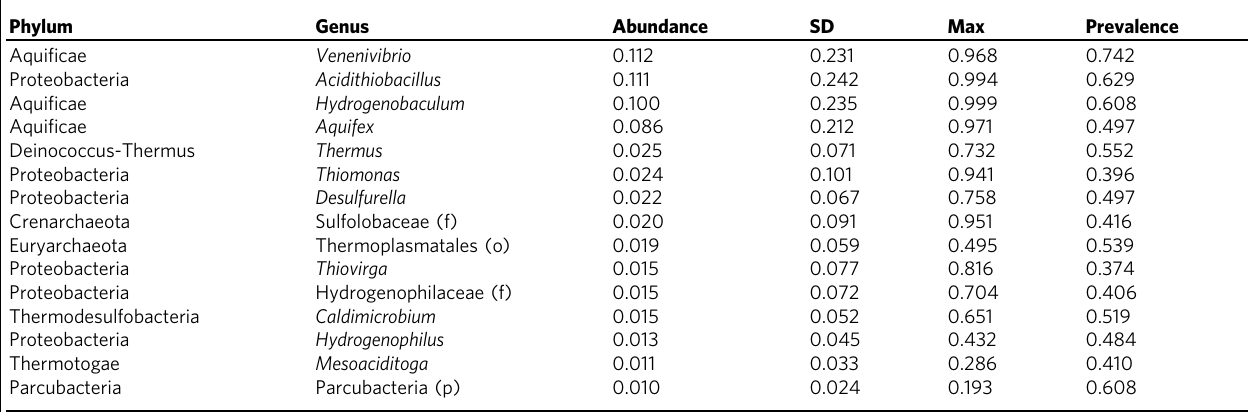
Table 1 Average relative abundance and prevalence of phyla and genera Phylum Genus